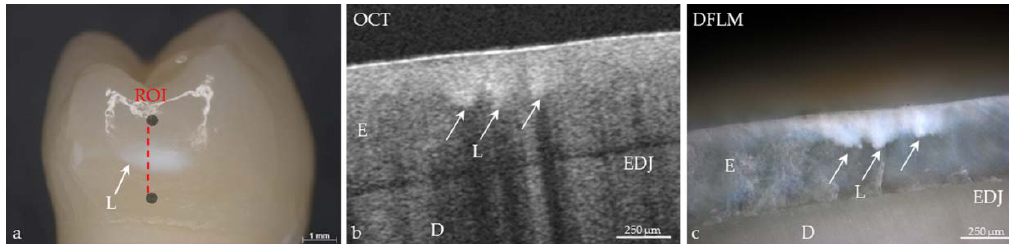
Figure 1. Conformance of visual assessment with optical coherence tomography. ( a ) Extracted human premolar with a carious lesion (L) of International Caries Detection and Assessment System (ICDAS II) Code 1. The lesion is visually detectable only after drying. Marks define the region of interest (ROI); ( b ) In the cross ‐ sectional image of the ROI, generated using spectral domain OCT, bright shadowed spots reveal the lesion area is limited to the first half of the enamel (E); ( c ) After sectioning, demineralization can be imaged using dark ‐ field light microscopy (DFLM) corresponding to the lesion details in the OCT image. D: dentin, EDJ: enamel ‐ dentin junction.